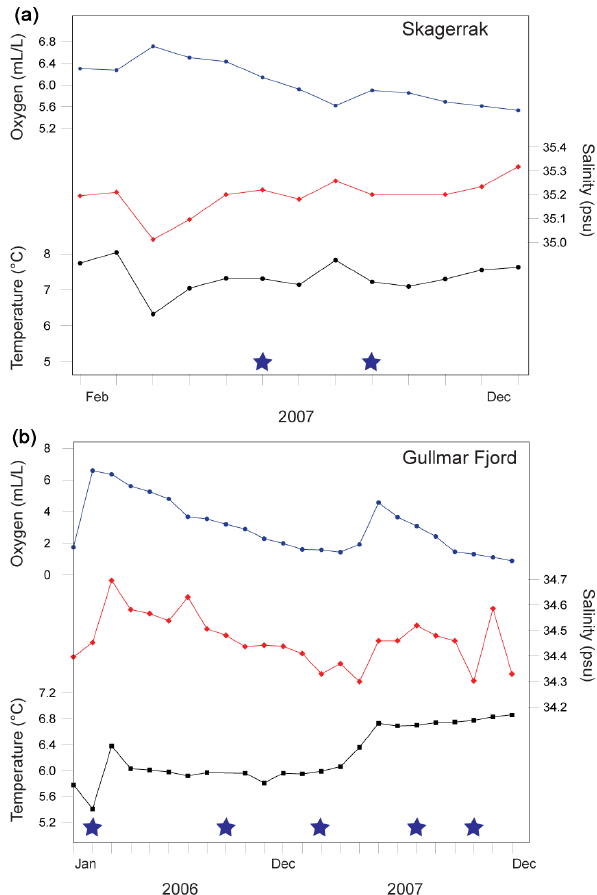
Fig. 2. (a) Annual cycle of temperature, salinity, and dissolved oxy- gen at 300m water depth at the location of site FÅ17 in the Sk- agerrak for 2007. (b) Temperature, salinity, and dissolved oxygen at 110m water depth at the location of site FG113 in the Gullmar Fjord for 2006 and 2007. Stars (lila) indicate the month of sampling of the living